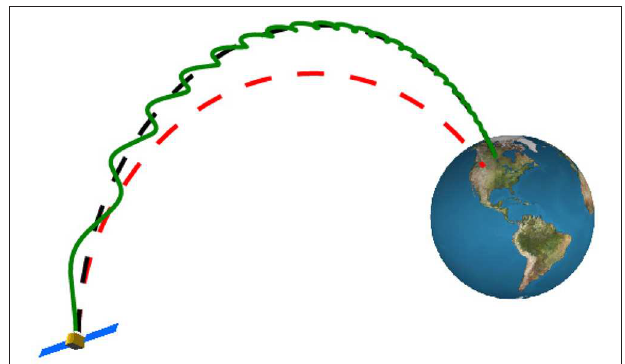
FIGURE 1 | Sketch of part of the proposed diagnostic system for tracing magnetospheric field lines. A change in magnetospheric conditions, and therefore field geometry (black dashed line shifted to the red dashed line), will result in movement of the beam impact location. Electron gyro-orbits of the beam are exaggerated for